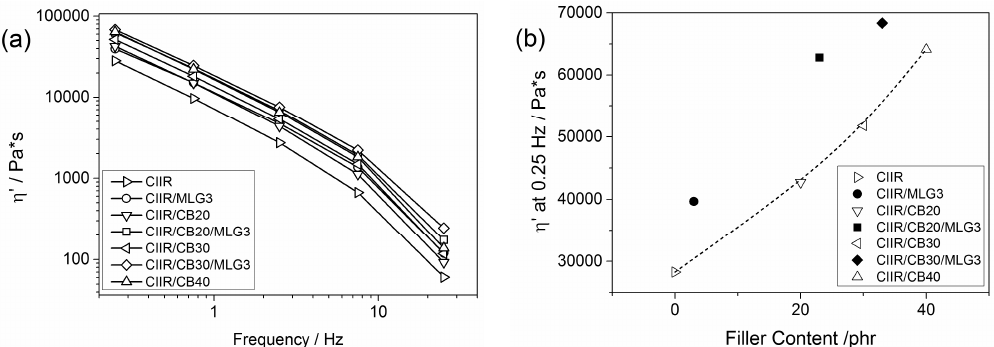
Figure 4. ( a ) Dynamic viscosity as a function of the frequency of CIIR and its composites; and ( b ) dynamic viscosity at 0.25 Hz as a function of the filler content; the line is a visual guide.